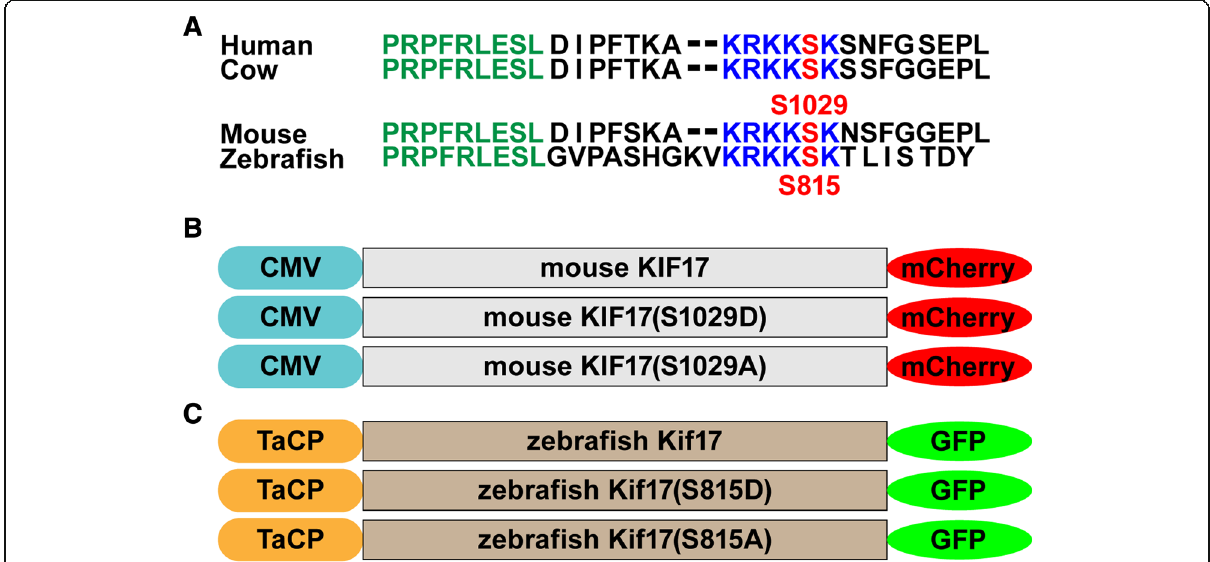
Fig. 1 Schematic of transgenic phospho-mutant KIF17 constructs. a The amino acid sequence of the C-terminus of KIF17 in various species is depicted. Homologous sequences are shown in color (green, blue, and red). The green conserved sequence has been shown to interact with the IFT-B complex [9], while the blue conserved NLS can regulate ciliary localization [8]. The conserved serine (red), mouse S1029/zebrafish S815, has been shown to be phosphorylated by CaMKII [16]. b For mammalian cell culture experiments (Additional file 1: Figures S1, S2), three different mCherry-tagged constructs of mouse KIF17 under control of the ubiquitous CMV promoter were generated: wild-type KIF17, phospho-mimetic KIF17(S1029D), and phospho-deficient KIF17(S1029A). c For zebrafish cone photoreceptor experiments, three different GFP-tagged constructs of zebrafish under control of the cone-specific transducin- α promoter (TaCP) were generated: wild-type Kif17, phospho-mimetic Kif17(S815D), and phospho-deficient